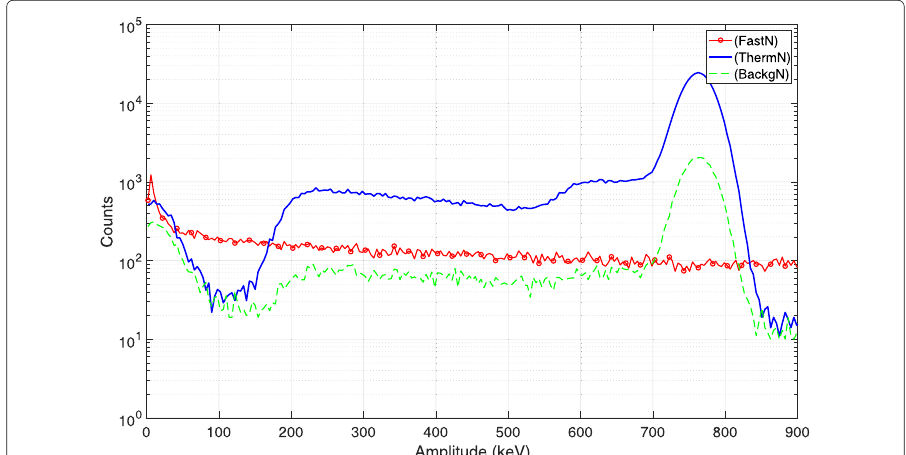
Fig. 7 Simulated total energy deposition for configurations (FastN), (ThermN) and